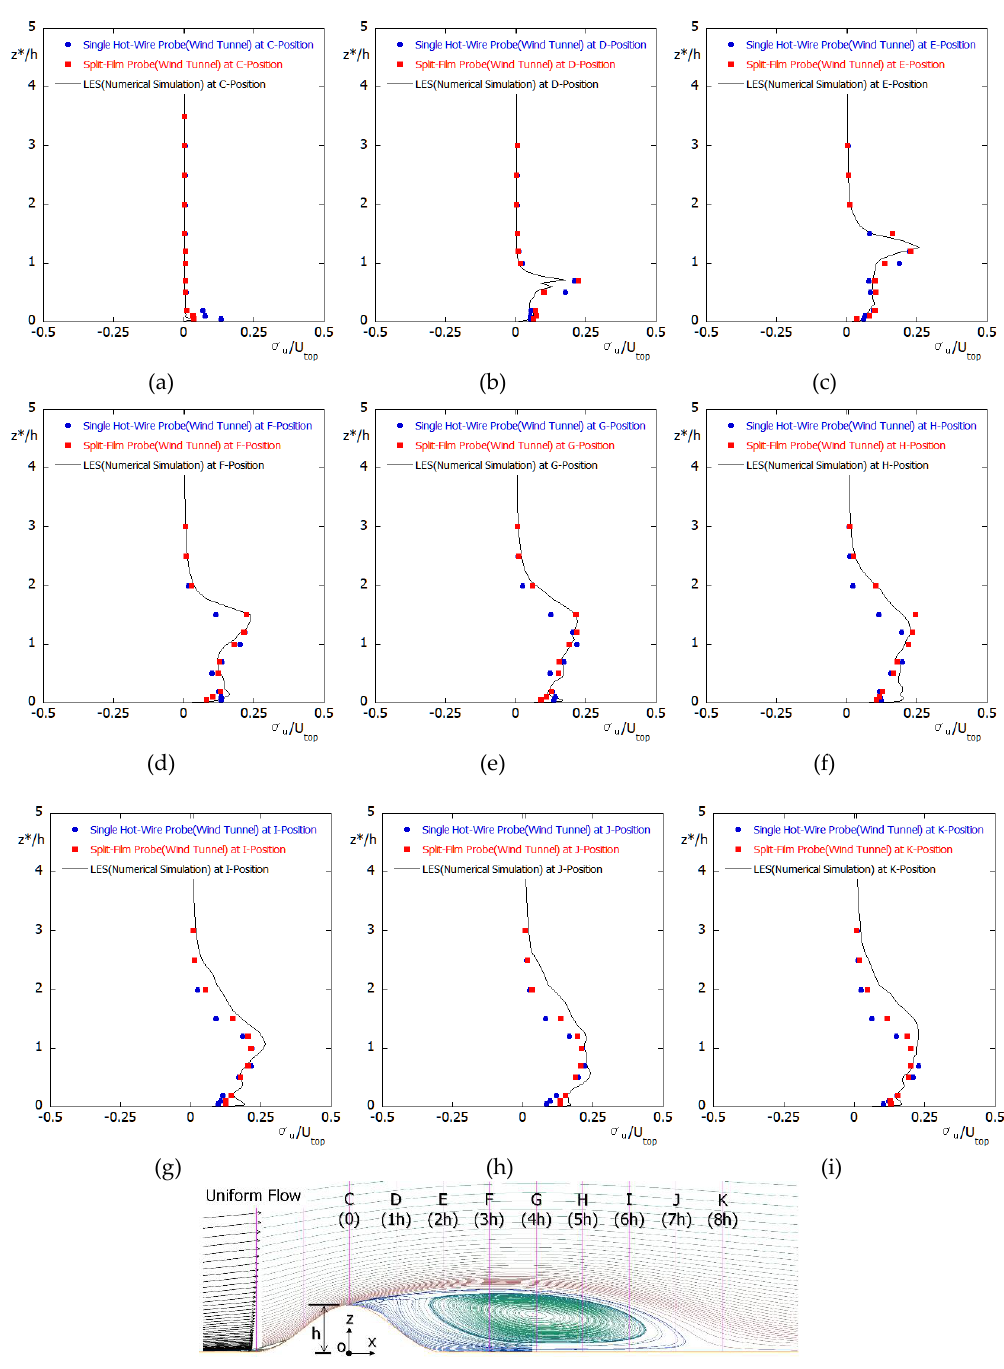
Figure 7. Comparison of nondimensional streamwise standard deviation profiles in the wind tunnel experiment and numerical simulation. Numerical flow visualization shows the flow field with time averaging and spatial averaging in the spanwise direction. ( a ) x = 0h, ( b ) x = 1h, ( c ) x = 2h, ( d ) x = 3h, ( e ) x = 4h, ( f ) x = 5h, ( g ) x = 6h, ( h ) x = 7h, and ( i ) x =